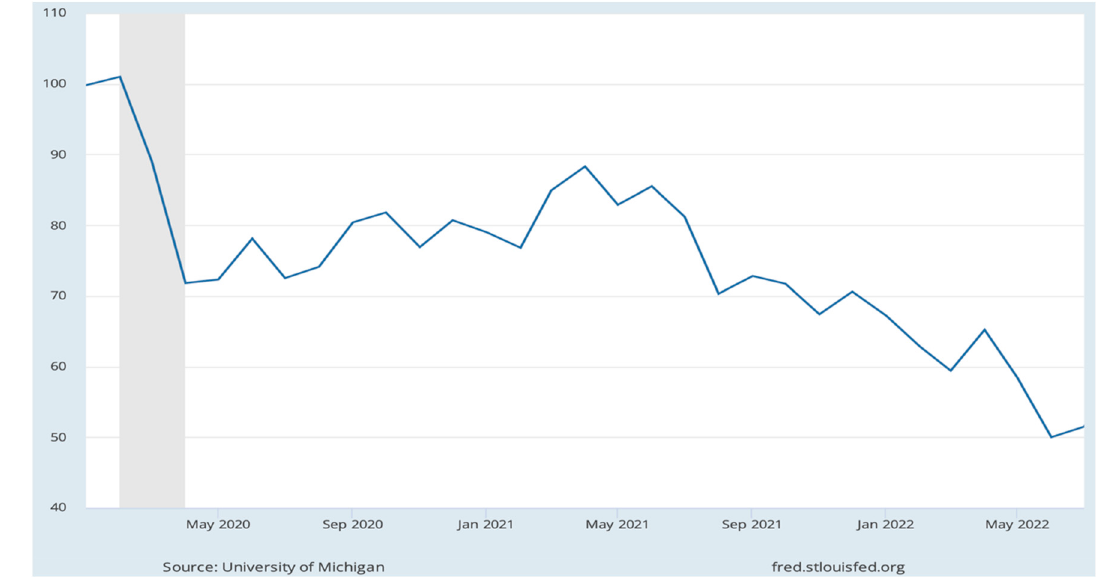
Figure 1. Consumer Sentiment. Table 1. Descriptive